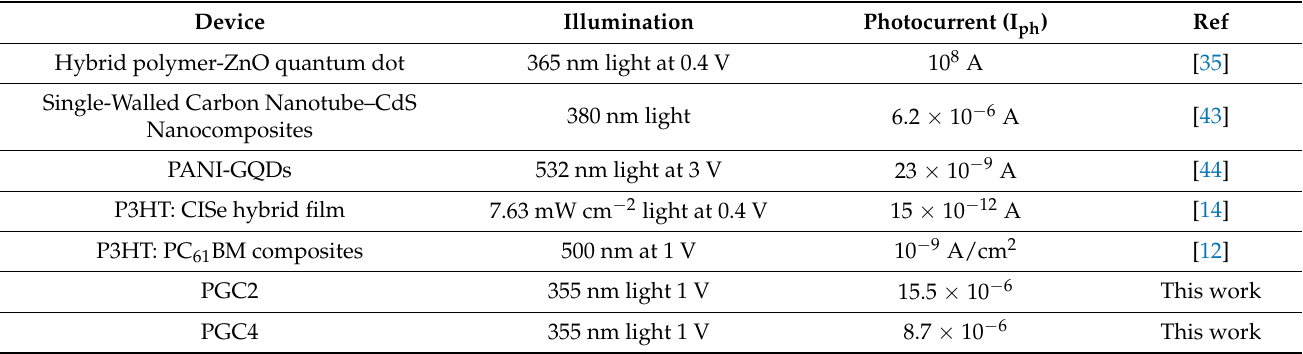
Table 3. A summary of the photoresponse comparison of previously published papers with our